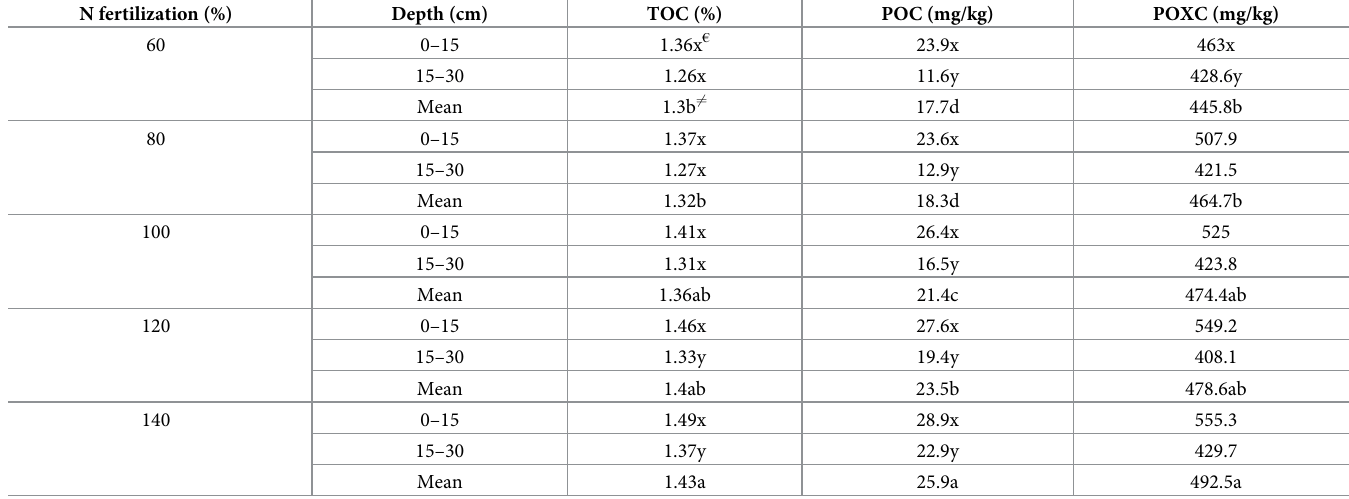
Table 2. Impact of nitrogen fertilization on soil depth distribution of total organic carbon, particulate organic matter, particulate organic carbon, and permanga- nate oxidizable carbon concentration. N fertilization